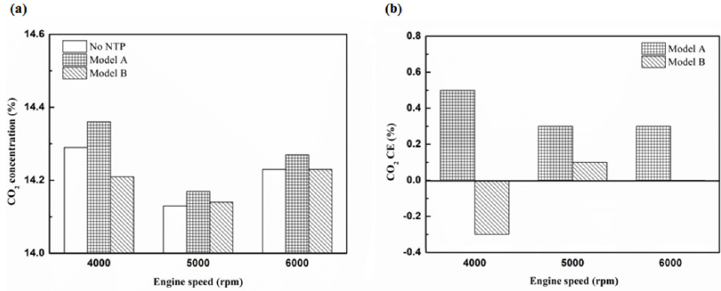
Figure 25. The CO 2 ( a ) emission values and ( b ) CE of control voltage 5 V using iridium alloy.